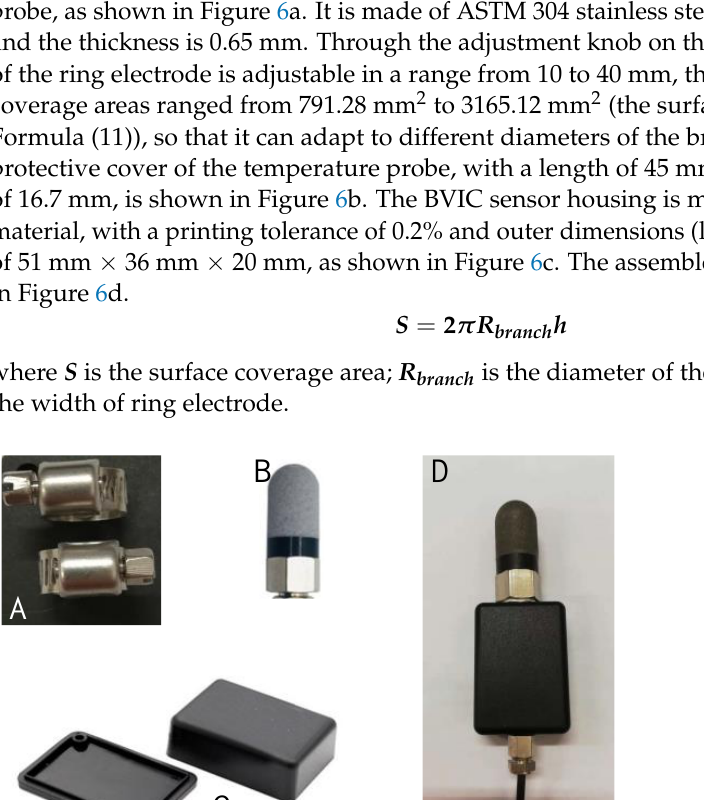
Figure 6. The BVIC sensor mechanical structure. ( A ) A bimetallic ring gauging probe. ( B ) The waterproof protective cover for the temperature probe. ( C ) Sensor housing. ( D ) The assembled BVIC sensor.